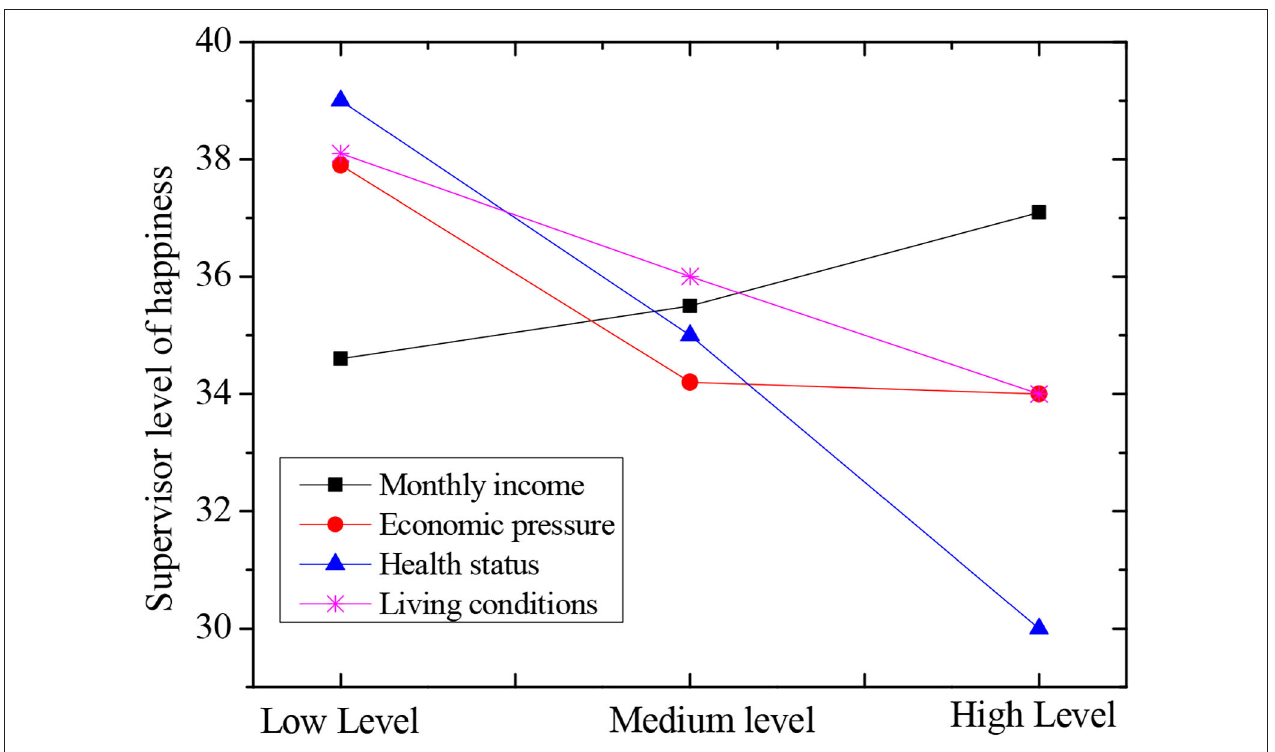
FIGURE 7 | Comprehensive evaluation of different influencing factors and happiness.